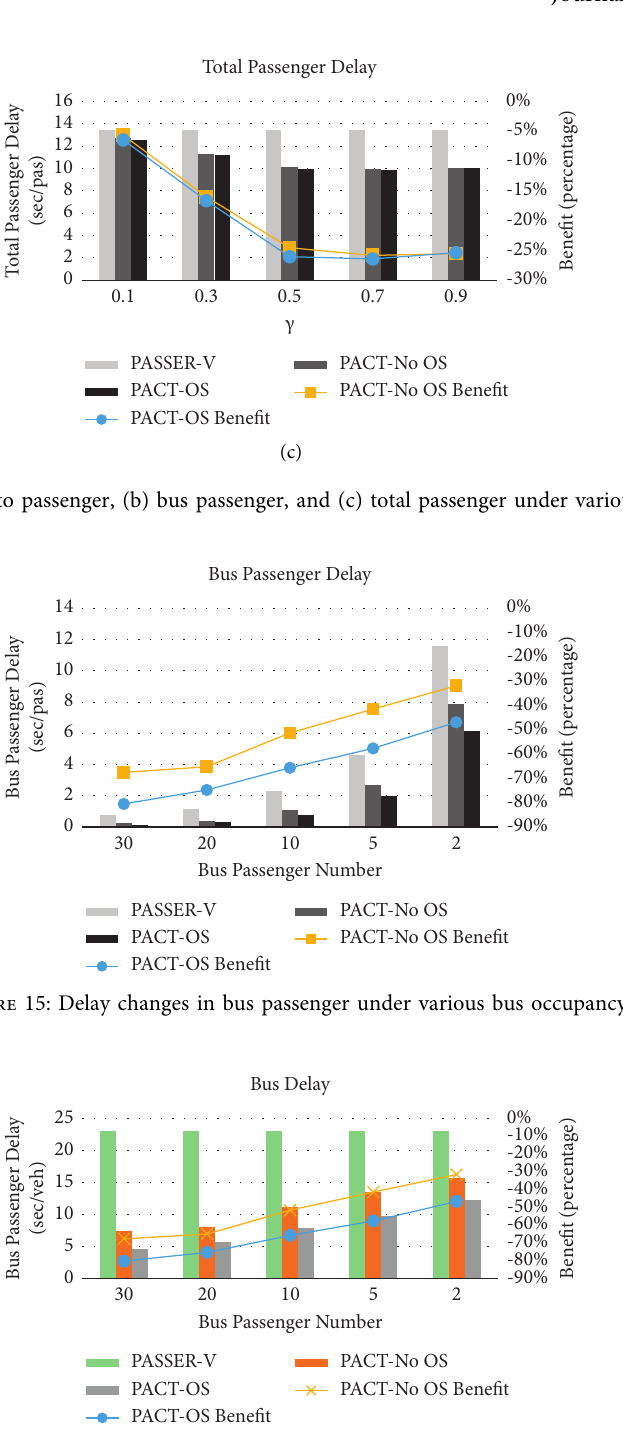
Figure 16: Delay changes in bus under various bus